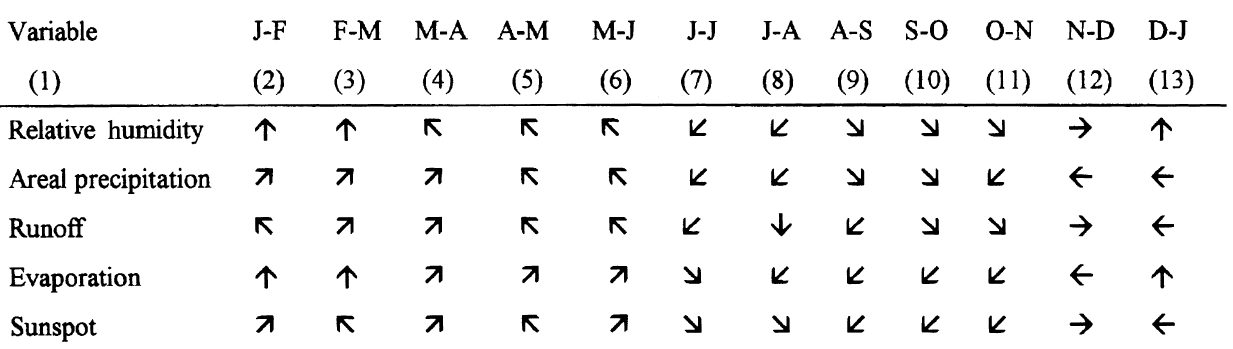
Table 1. Lake level fluctuations relationship to various